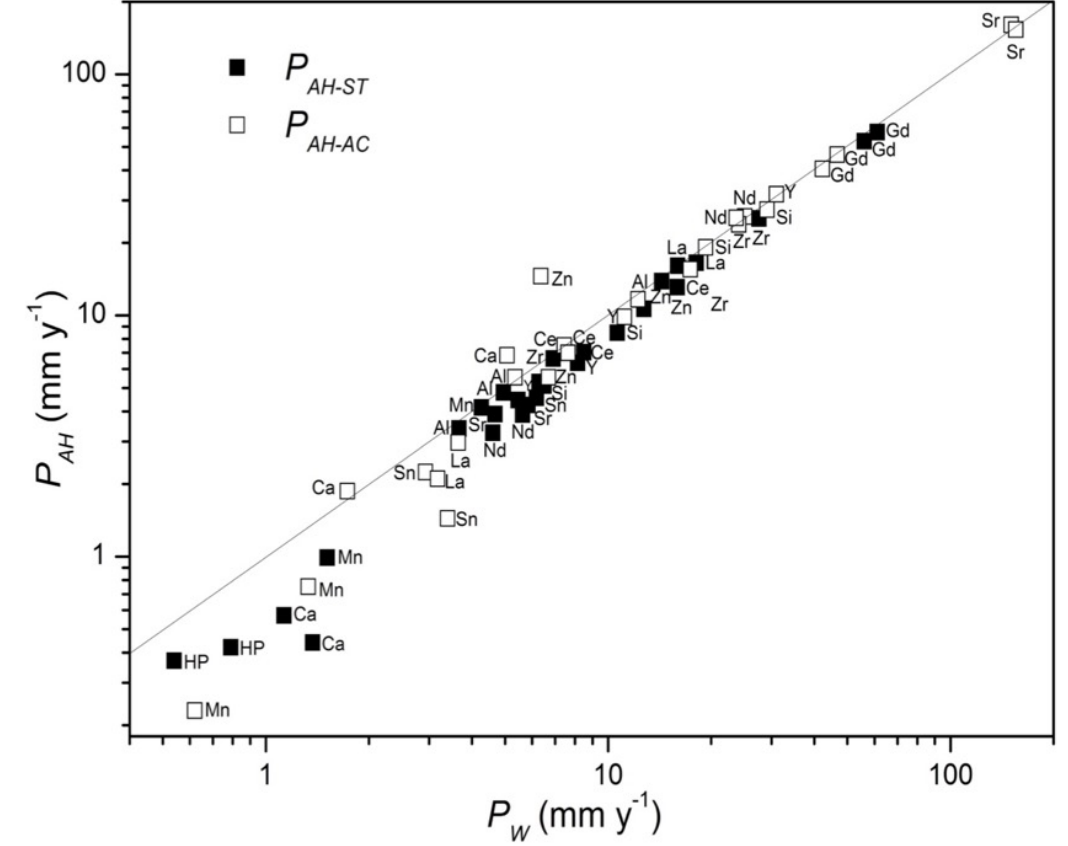
Figure 2. A cross plot [81] of independent measurements of the average corrosion rate evaluated from the total volume of evolved hydrogen, P AH , plotted against the average corrosion rate over the experimental duration measured from the weight loss, P W . Open symbols represent data from solution treated alloys. Full symbols represent data from as-cast alloys.